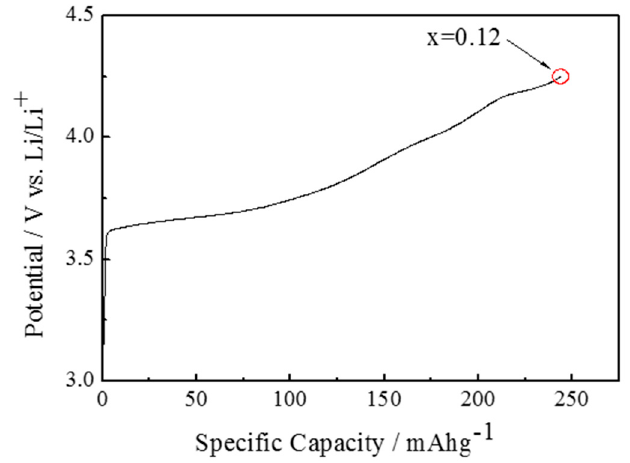
Figure 1. Charge curves of Li x Ni 0.874 Co 0.090 Al 0.036 O 2 cathode material at a constant current density of 0.01 C.